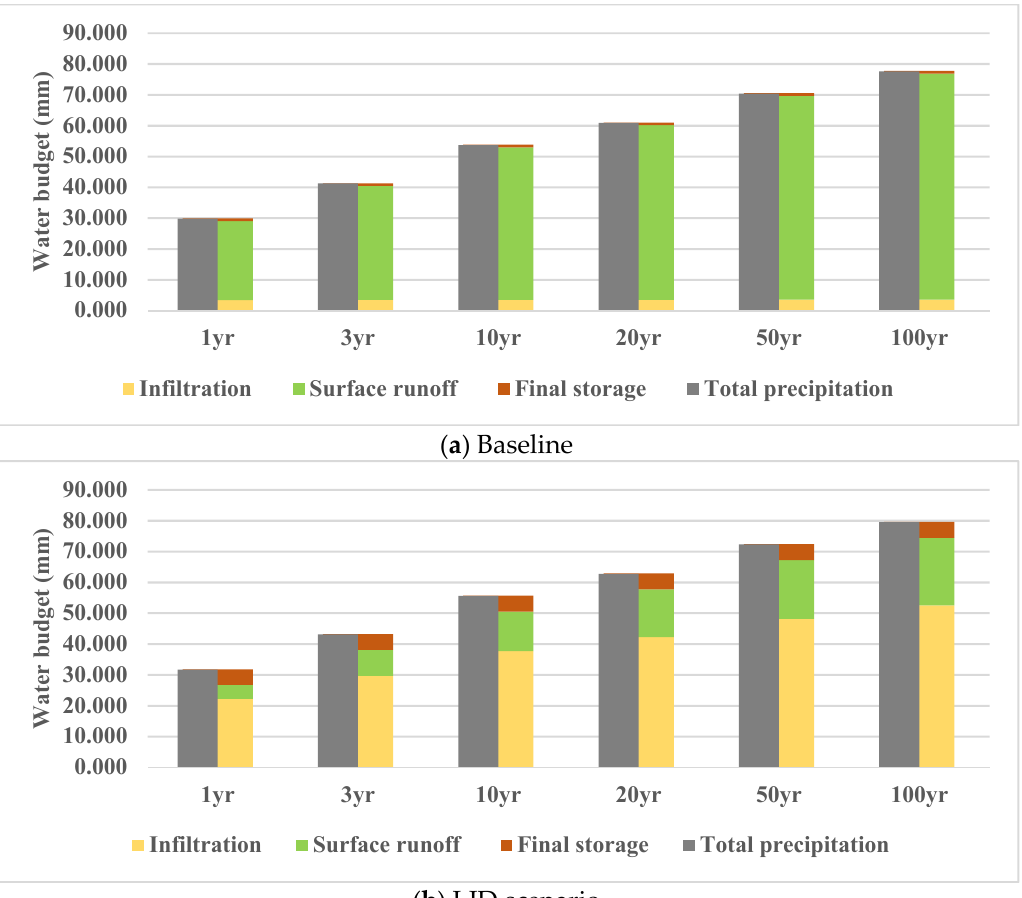
Figure 5. The simulated water budgets driven by different design storms in the baseline ( a ) and LID scenario ( b ).